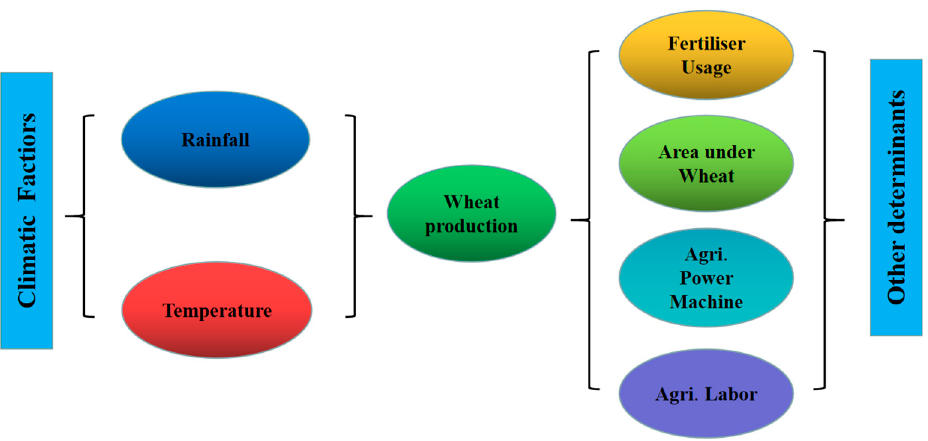
Figure 3. The study’s conceptual framework.